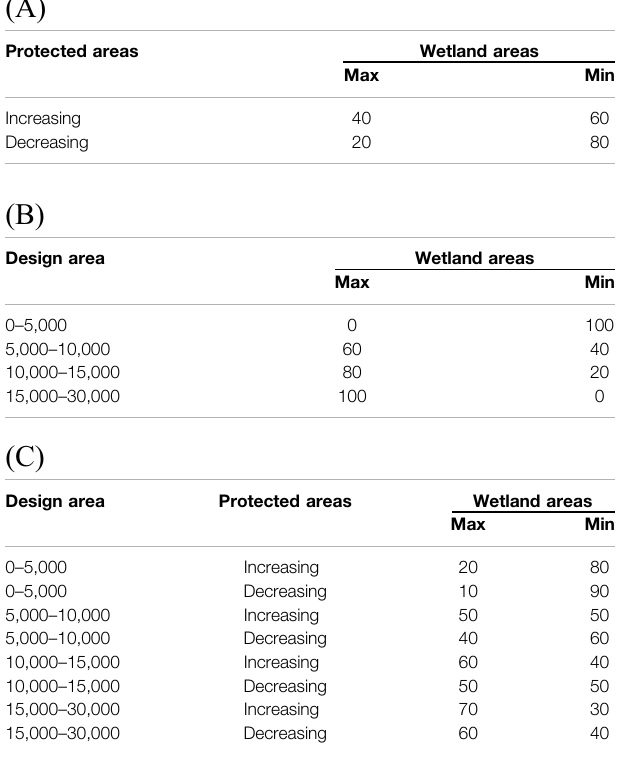
TABLE 5|(A) CPT ofthevariable “ Wetland areas ” inthestakeholder-basedBBN. (B) CPT of the variable “ Wetland areas ” in the hydraulic-based BBN. (C) . CPT of the variable “ Wetland areas ” in the combined